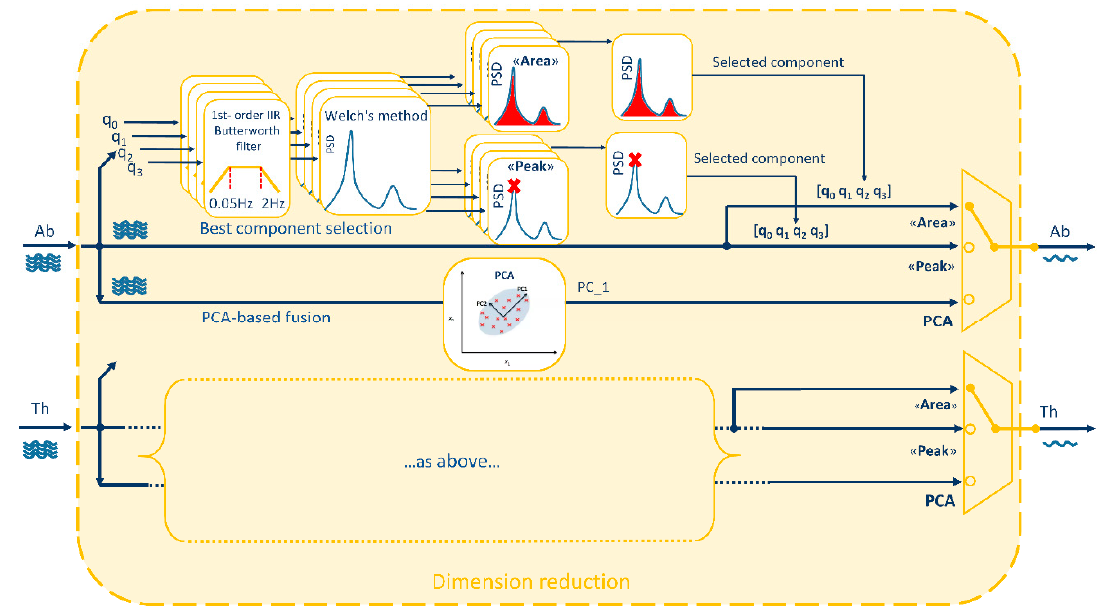
Figure 2. Dimension-reduction block in detail. Starting from the 4 components [q 0 , q 1 , q 2 , q 3 ] of each quaternion (Abdominal: Ab and Thoracic: Th), three methods are applied to obtain a single-component signal: two methods based on best quaternion component selection (“Area” and “Peak”) and one method based on the fusion of the 4 components through Principal Component Analysis (PCA). “Area” method selects the quaternion component with the larger area under the Power Spectral Density (PSD) estimate, while “Peak” method selects the quaternion component with the highest PSD’s peak. PCA-fusion method selects the first principal component (PC_1) that accounts for the largest variance in the data.